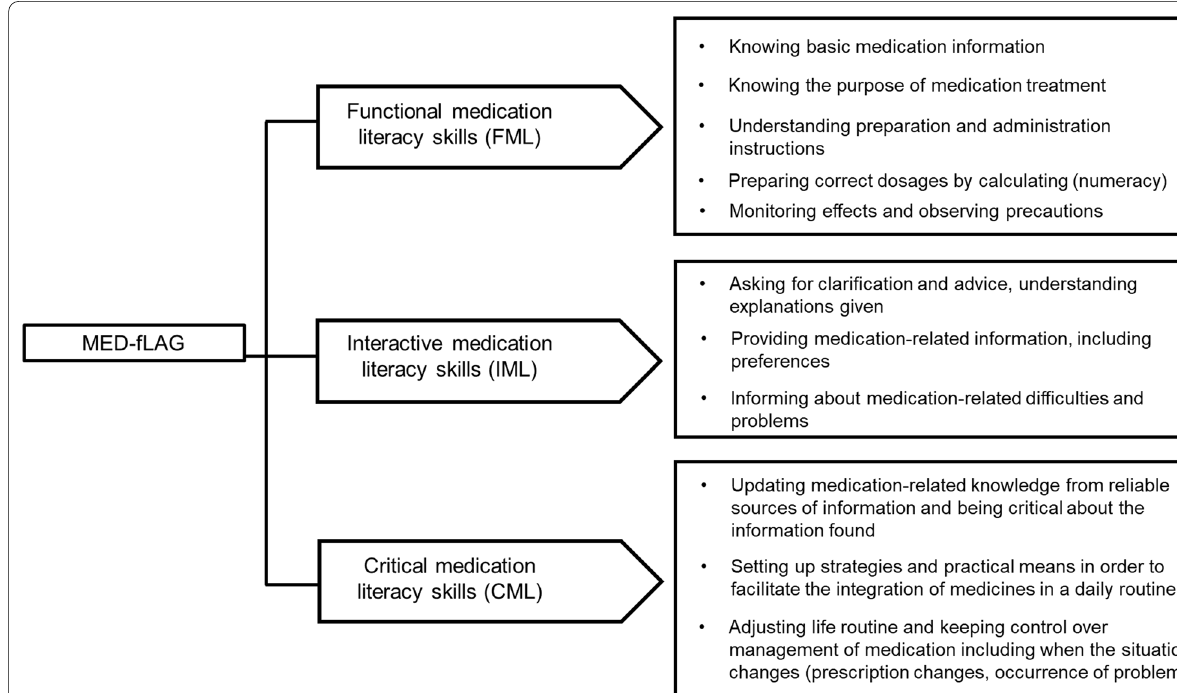
Fig. 1 The medication literacy domains of functional (FML), interactive (IML) and critical skills (CML), and associated